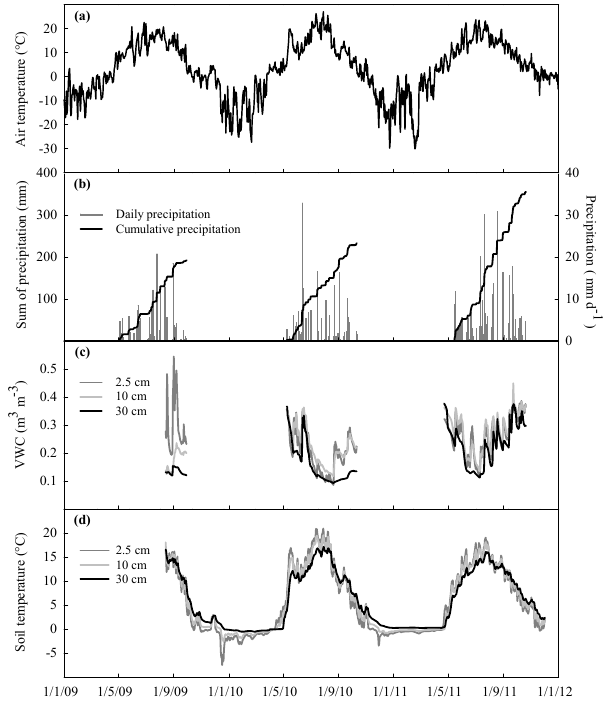
Figure 1. Climatic conditions at the study site during the measure- ment years. (a) Daily averaged air temperature ( ◦ C) during 2009– 2011, (b) Daily precipitation (mmd − 1 , grey line) and its cumula- tive sum (mm, black line) during the growing seasons. (c) Daily av- eraged volumetric water content (VWC, m 3 m − 3 ) at 2.5cm (dark grey line), 10cm (light grey line) and 30cm (black line) during the growing seasons, from 14 August 2009 onwards. (d) Soil tempera- tures ( ◦ C) at the 2.5cm (dark grey line), 10cm (light grey line) and 30cm (black line) depths as daily means from 14 August 2009 until 2 December 2011.